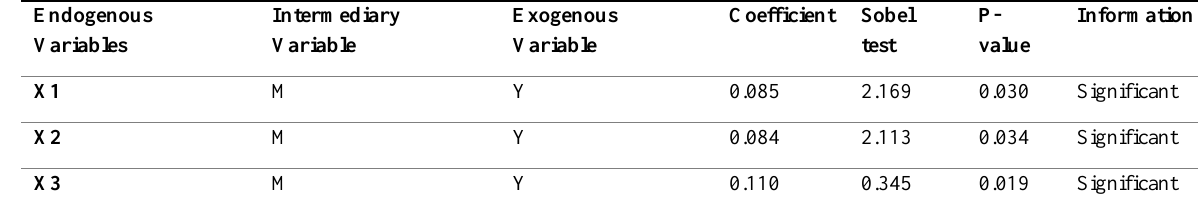
Table 4: Results of Indirect Effect Hypothesis